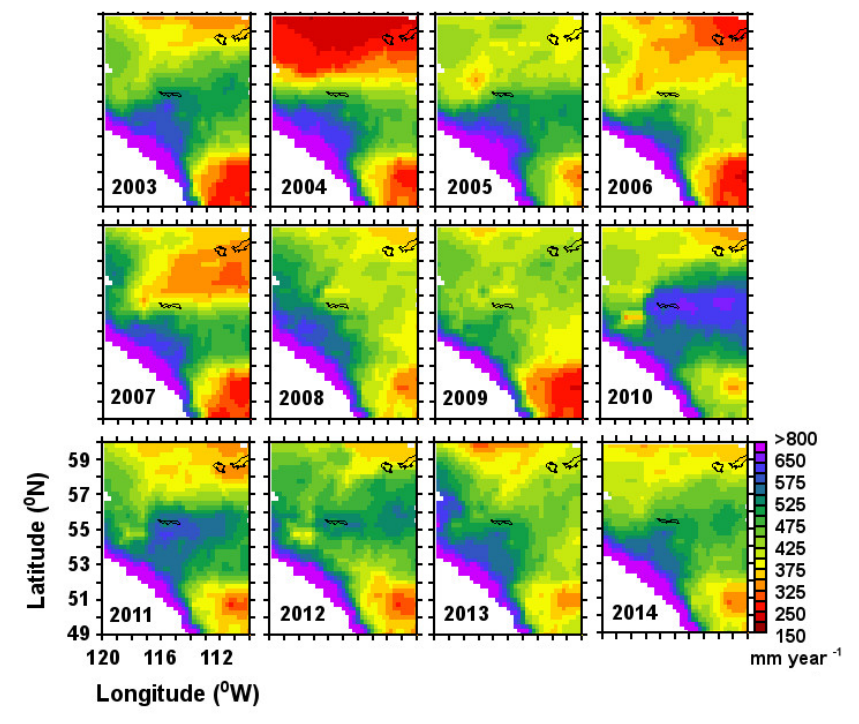
Figure 2. Annual precipitation rates (mmyear − 1 ) in Alberta between 2003 and 2014.